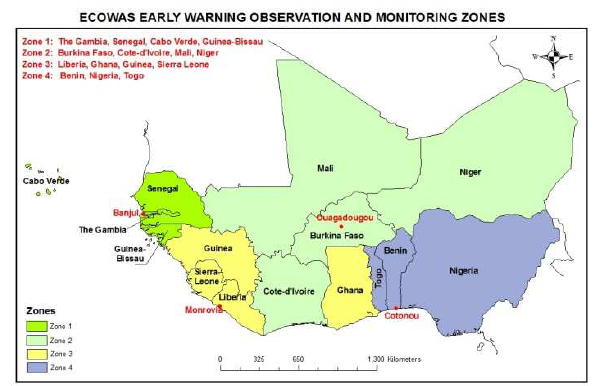
Figure 1. - ECOWAS Early Warning Observation zones by